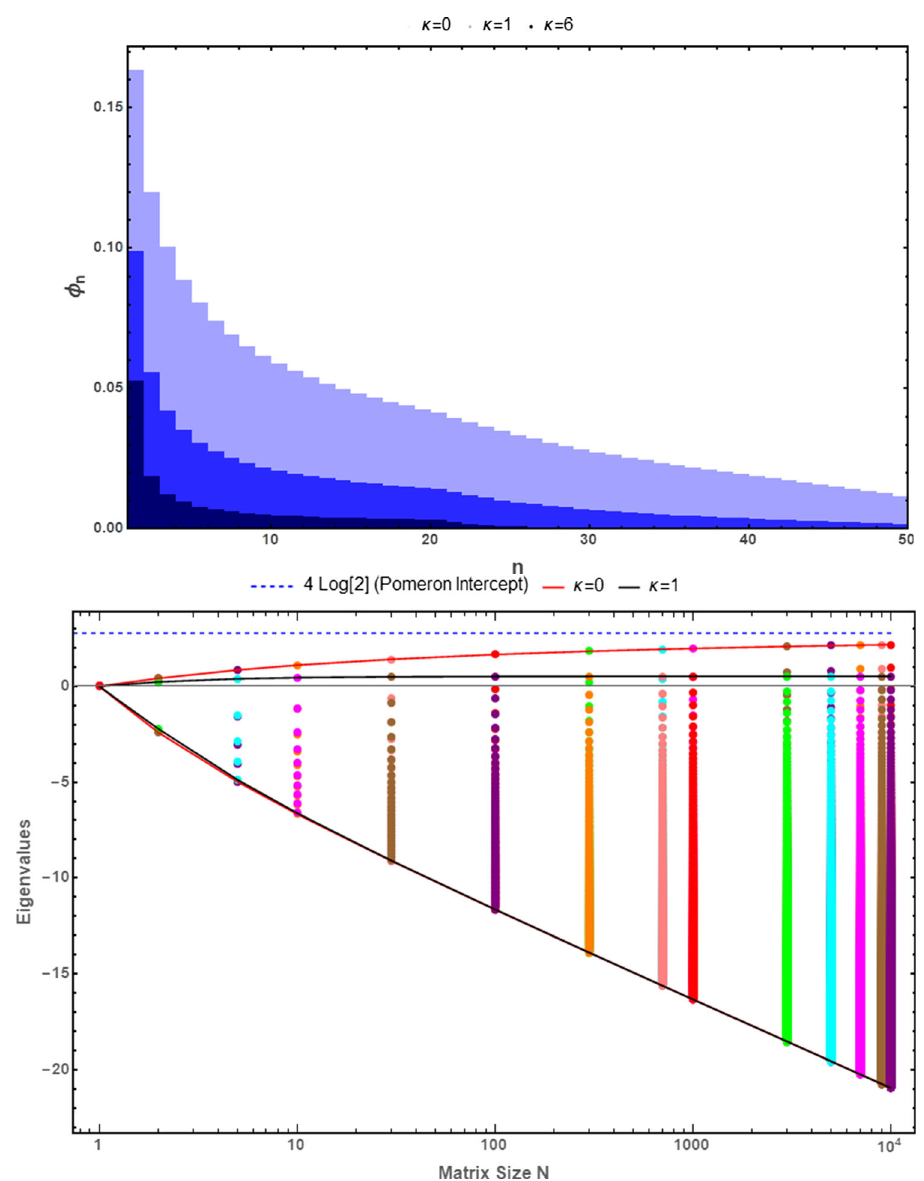
comparison for κ = 0 , 1 , 6.